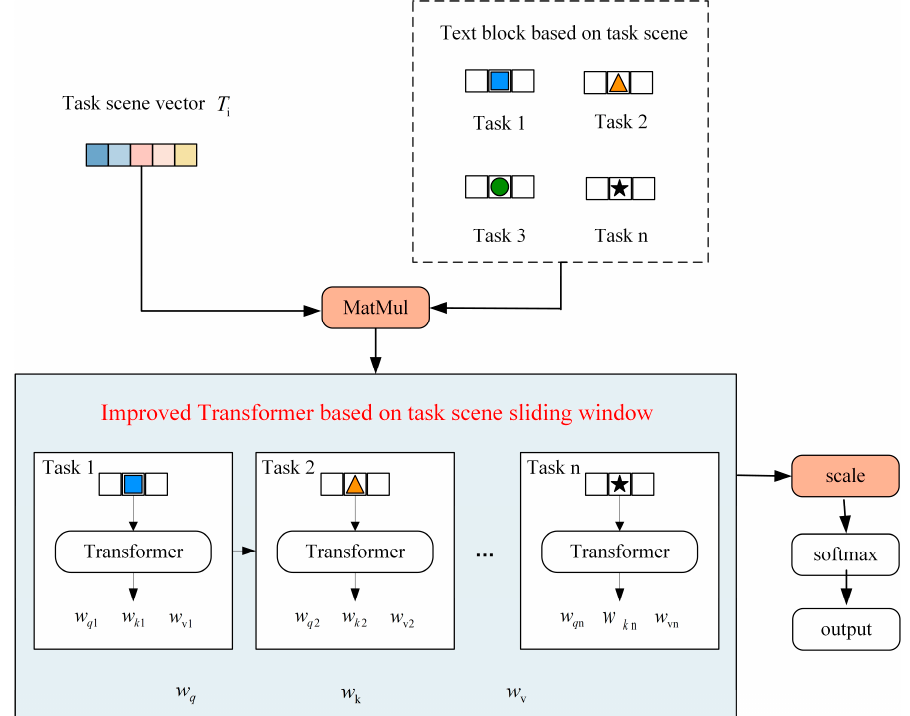
Figure 3. Transformer model diagram based on task scene sliding window.